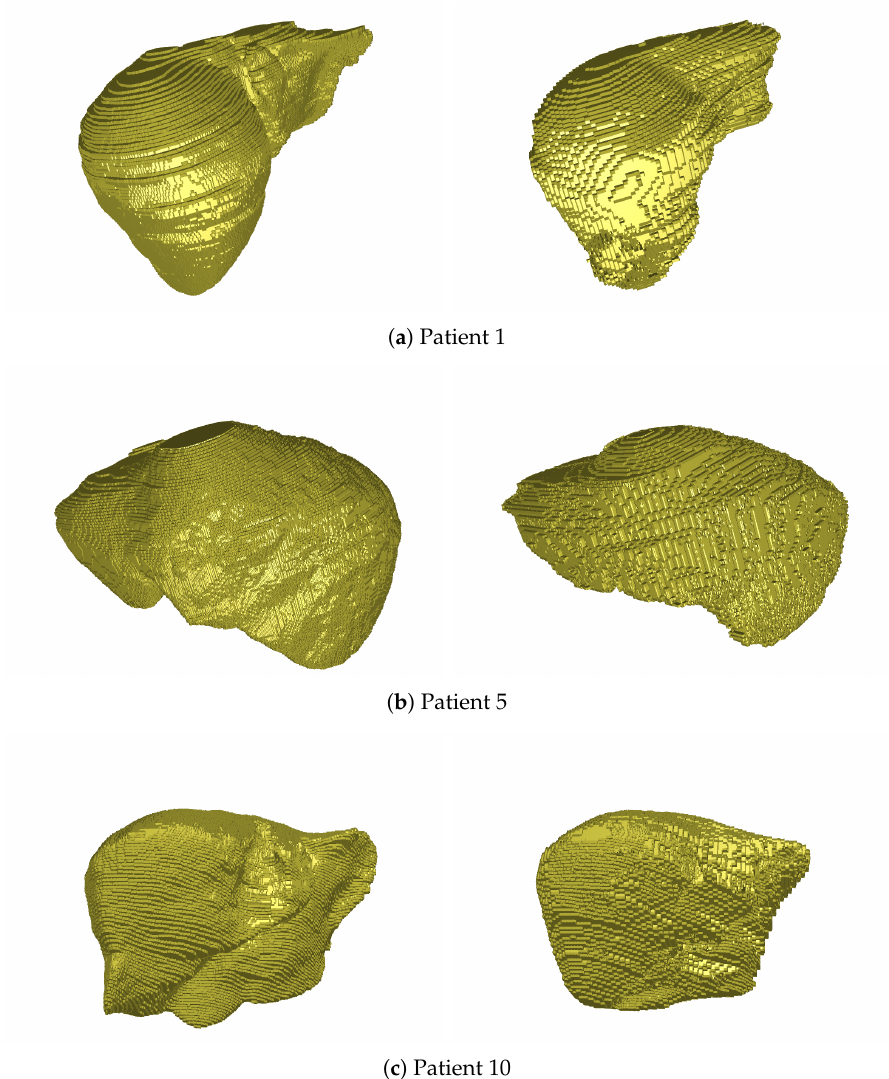
Figure 4. 3D views of liver volume segmentations obtained from several patients of the IRCAD dataset (right). For each case, the ground truth is also depicted